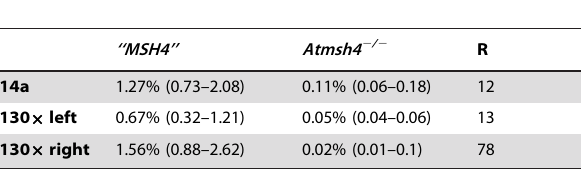
in CO rates at the 14a loci. Strikingly, the 14a hotspots almost disappeared in ColxPyl-1. There were 100 times less COs than in ‘‘ MSH4 ’’, 60 times less than in ColxL er and 23 times less than in ColxWs and even 12 times less than in the mutant Atmsh4 2 / 2 background (Table 4; Figure 8A). In ColxWs, the CO rate (0.21%) was in the same range as in ColxL er (0.55%) but significantly less than in ‘‘MSH4’’ (1.27%; Table 4). Table 1. CO rates in Atmsh4 at 130 6 and 14a.